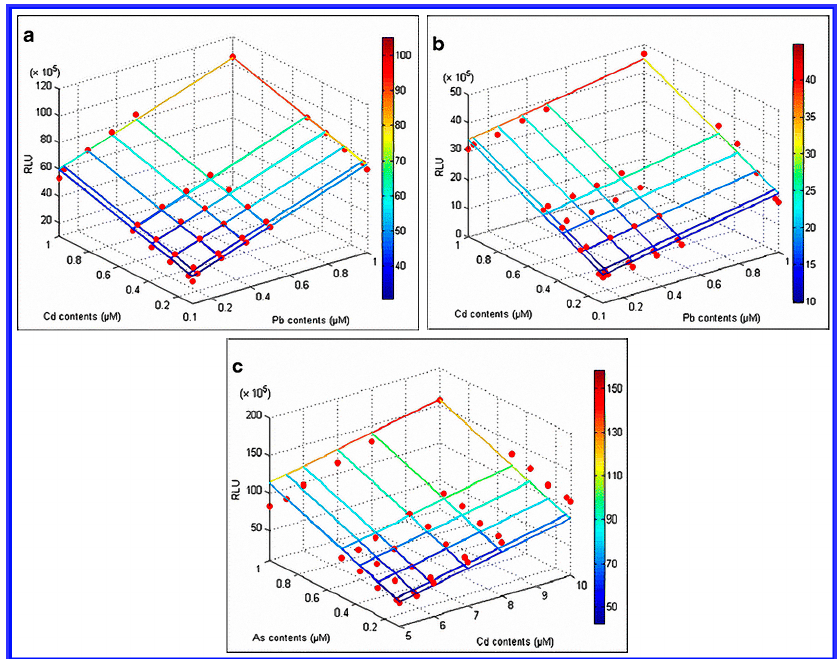
Figure 5. Binary linear regressions of ( a ) a pcdCluc sensor in Group 1 to Cd-Pb mixtures; ( b ) a pzntRluc sensor in Group 1 to Cd-Pb mixtures; and ( c ) a parsRluc sensor in Group 2 to As-Cd mixtures are given. Reprinted with permission from [77].